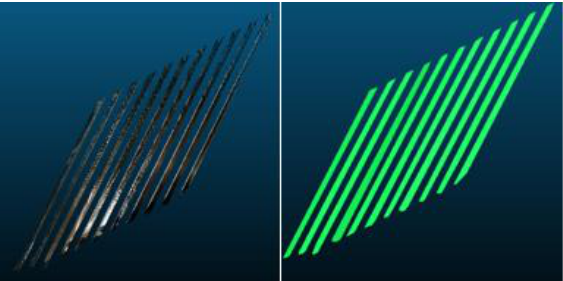
Figure 11. The as-built point cloud for eleven girders in Span 1 and their 2D polygon fitting results.